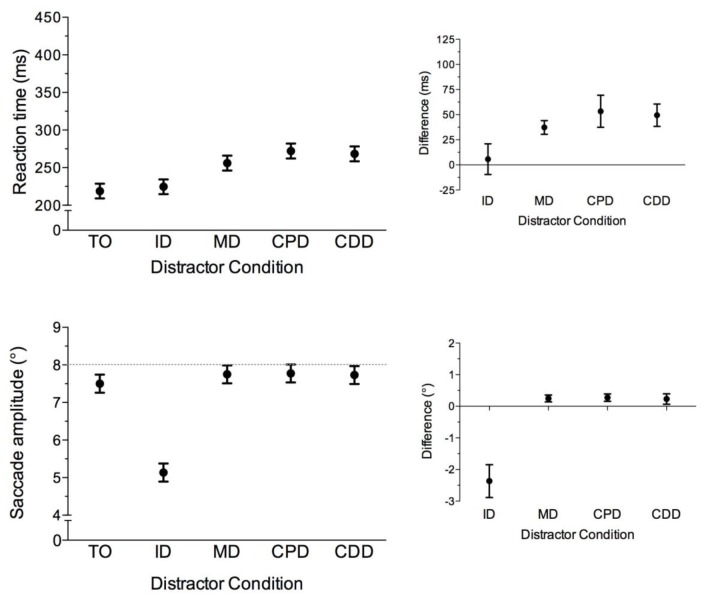
The main panels depict mean reaction time (ms) (i.e., upper panel) and saccade amplitude (°) (i.e., lower panel) for the supplemental experiment wherein prosaccades across TO, ID, MD, CPD, CDD trial-types were completed with target- or target and distractor vision throughout response execution.Results for RT showed that TO and ID conditions produced equivalent RTs, t(9) = 0.85, p = 0.42, whereas RTs for MD, CPD, and CDD conditions were greater than the TO condition, ts(9) > 7.57, ps < 0.001. Error bars for these panels represent within-participant 95% confidence intervals [28] and were computed based on the mean-squared error term for trial-type. The right offset panels show the mean reaction time and saccade amplitude difference scores. Error bars represent between-participant 95% confidence intervals [29, 30]. The absence of overlap between error bars and zero (i.e., horizontal axis) provides a graphical depiction of a reliable difference that can be interpreted inclusive to a test of the null hypothesis. Further, we note that Benson [37] employed a RDE paradigm wherein target and distractor vision was available throughout response execution and the target direction was randomized between left and right visual space. In contrast to Walker et al. [2], Benson reported a larger RDE magnitude for contralateral—compared to central—distractors. In line with Benson, prosaccade RT difference scores associated with the remote distractor conditions in the supplemental experiment yielded a significant main effect, F(1,9) = 7.09, p < 0.01, such that the contralateral distractors (i.e., CPD: 53 ms; SD = 22, CPD: 49 ms; SD = 15) produced a larger magnitude RDE than the midline distractor (i.e, MD condition: 37 ms; SD = 9), ts(9) > 2.79, ps < 0.05.